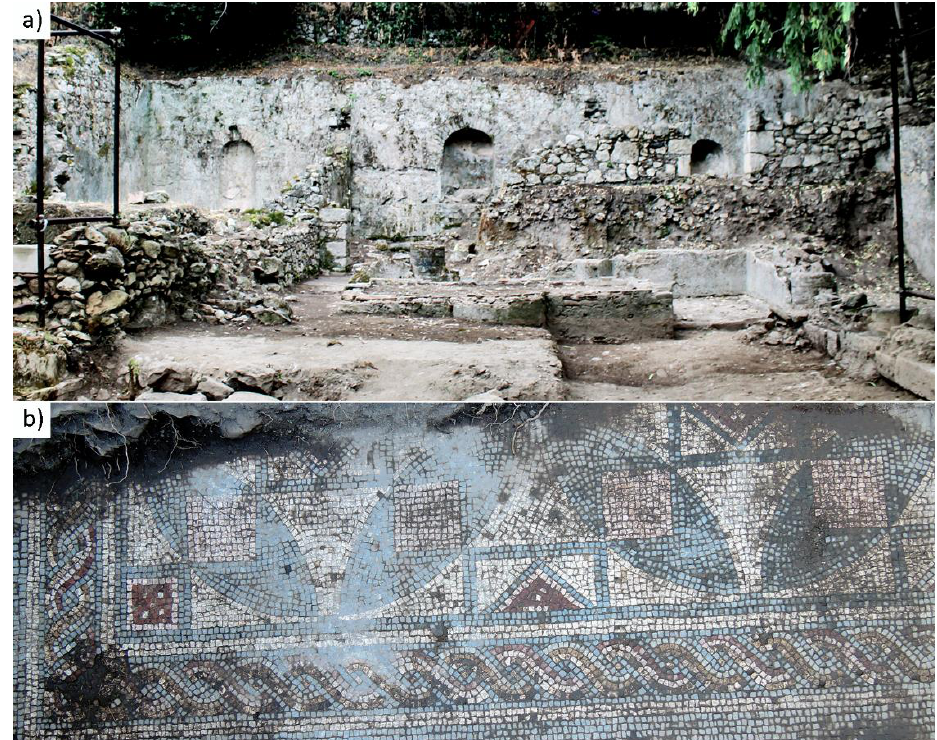
Figure 3. Domus 1; ( a ) view of the southern aisle of the court with Rooms 16, 17 and 18; and ( b ) polychrome mosaic in Room 17.